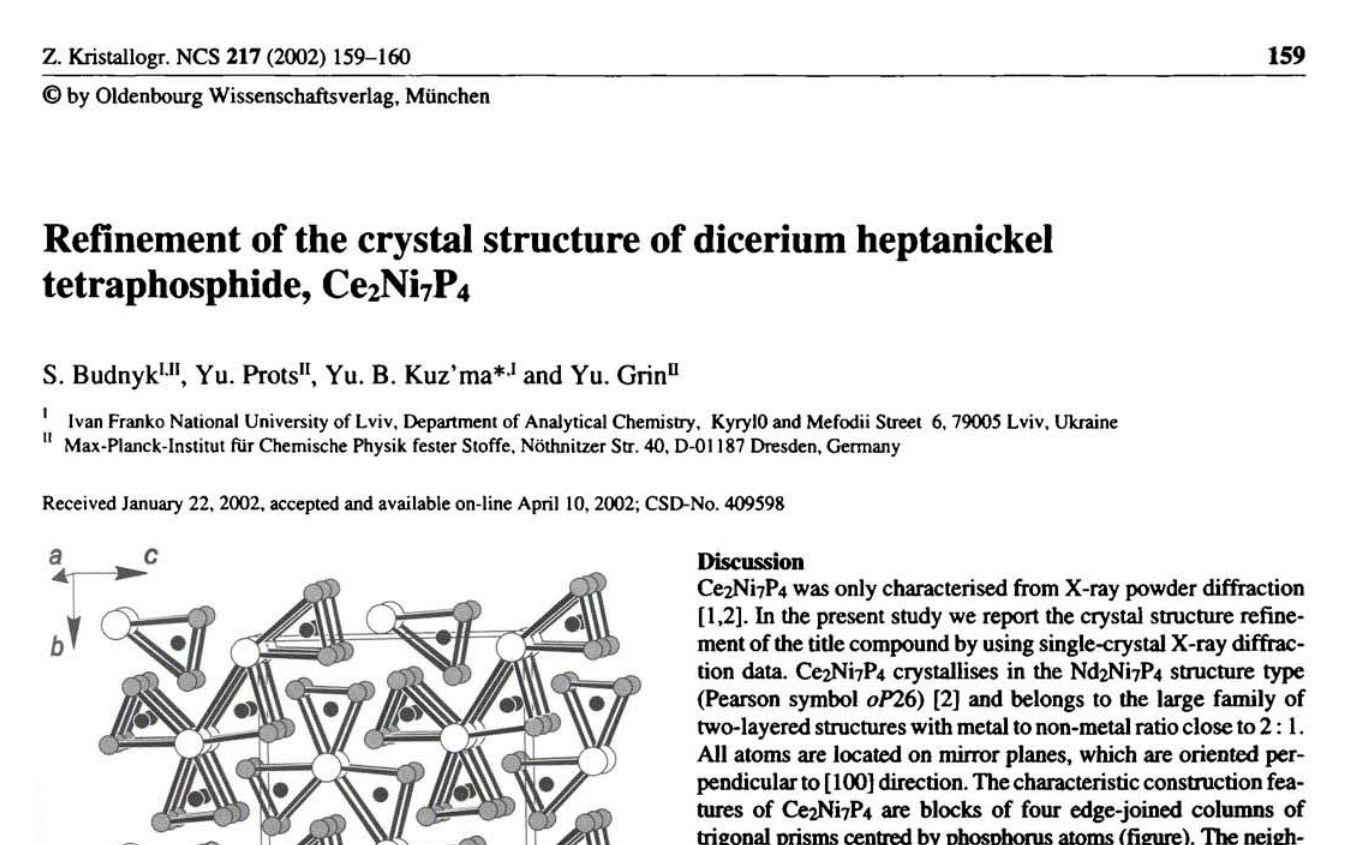
Table 1. Data collection and handling.